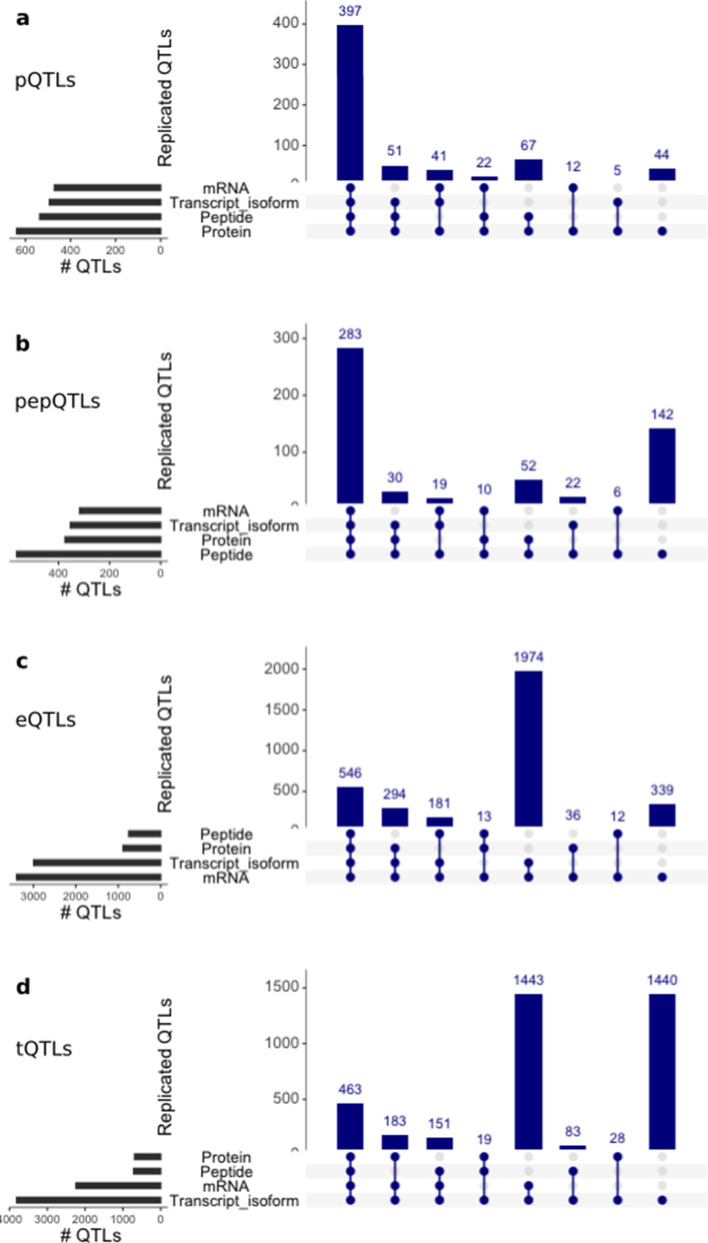
Discovery and replication of cis QTLs at protein and RNA levels.Upset plots showing from top to bottom: genome-wide significant cis QTLs (FDR < 10%) for protein (pQTLs), peptides (pepQTLs), gene expression (eQTLs) and transcript isoforms (tQTLs) summarised at gene level. For each discovery set the replication (i.e. nominal PV <0.01 and effect sizes of the same direction) is assessed in the respective other layers, and the number of genes with replicated effects for each intersection is displayed. For comparison purposes, we show only QTLs assessed in all the four layers.